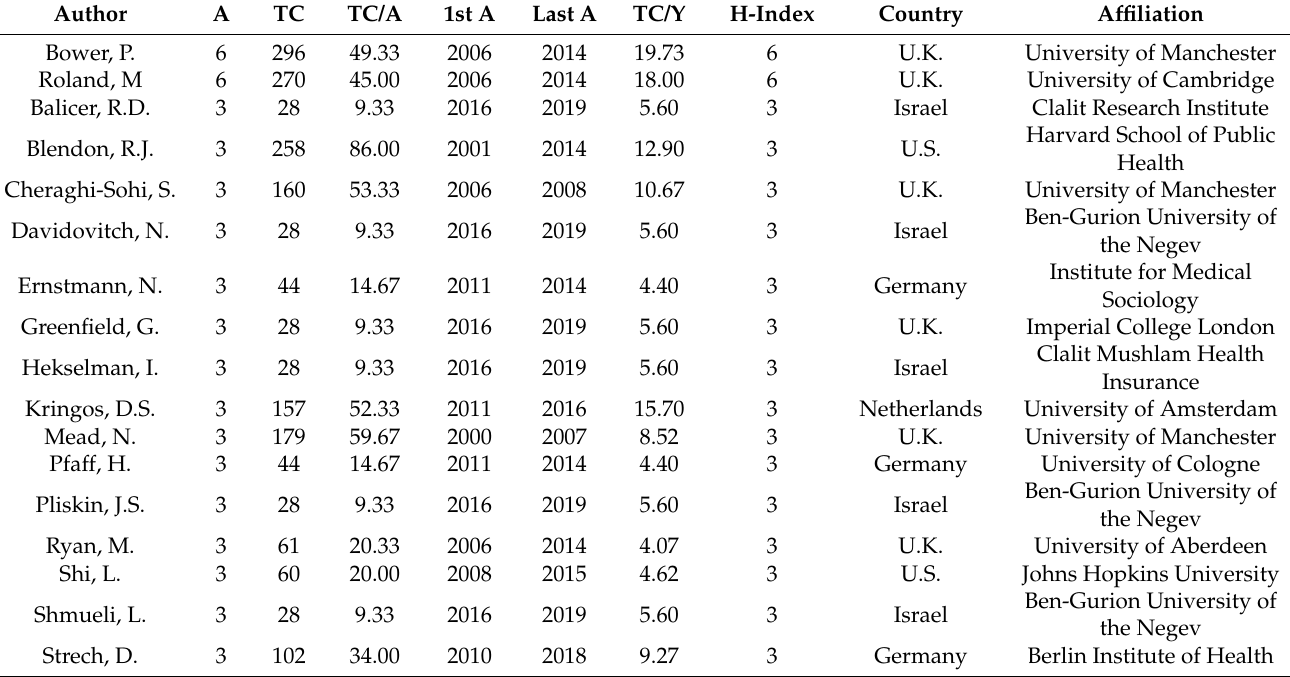
Table 5. The top 17 most productive authors on PS and HP research.